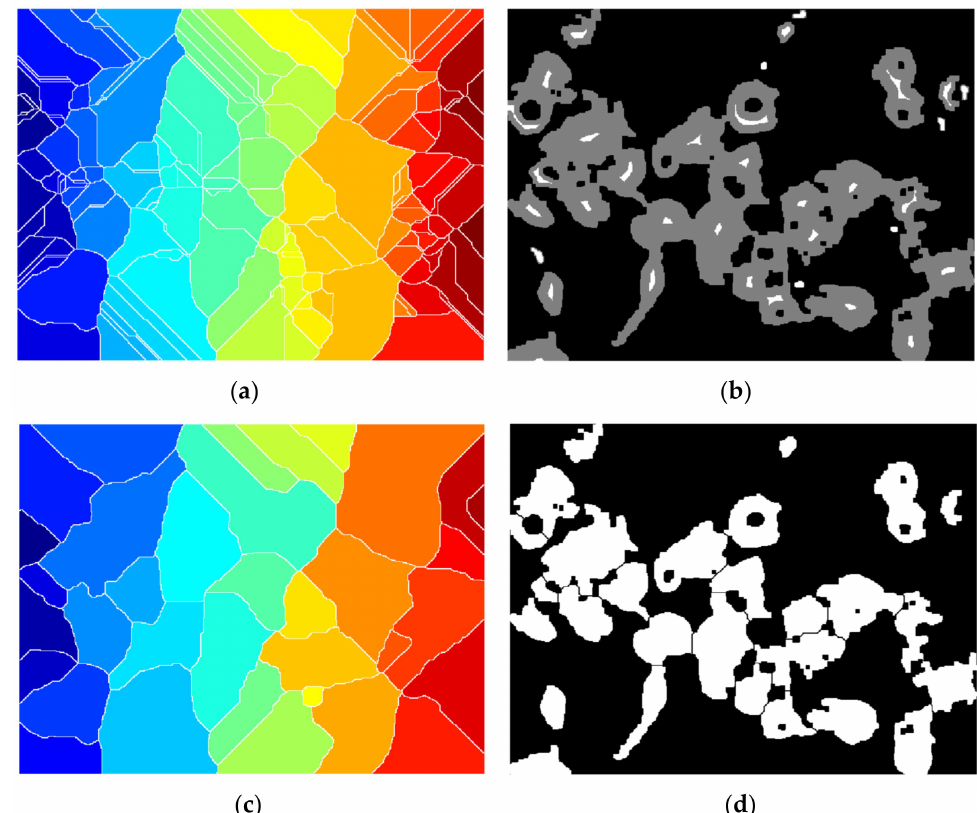
Figure 12. ( a ) Over-segmentation watershed transform; ( b ) nucleus mask over binary image; ( c ) watershed transform with ( b ) imposed; ( d ) segmented